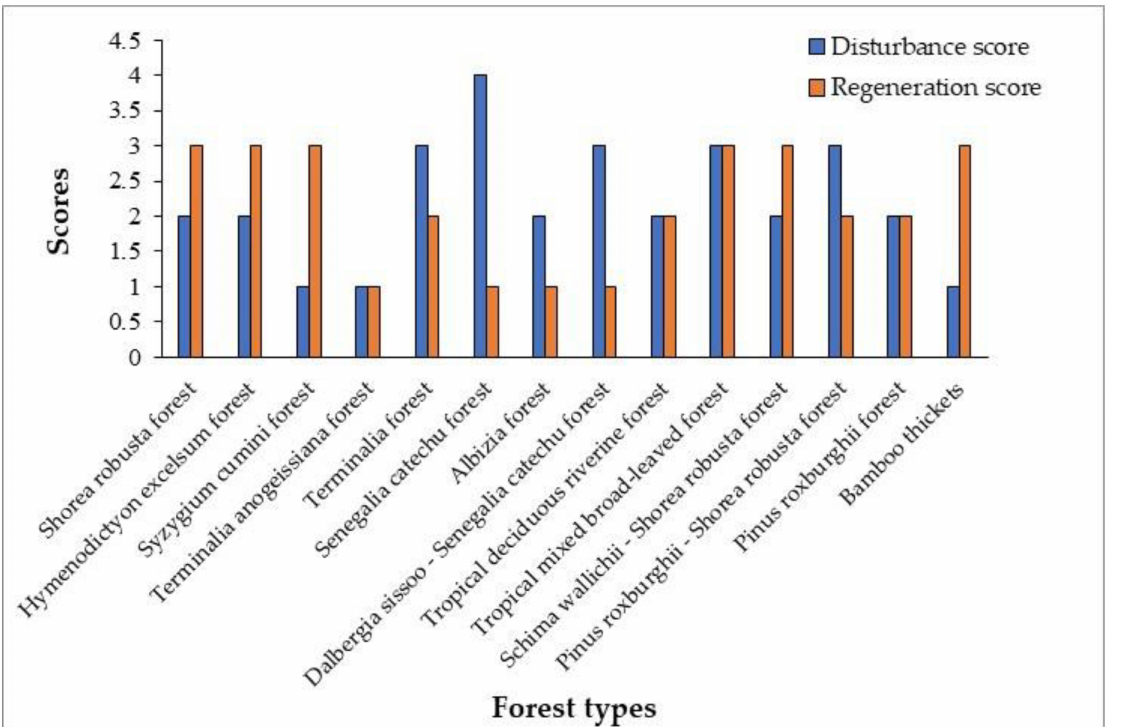
Figure 4. Disturbance and regeneration score according to forest ecosystem types in Chure